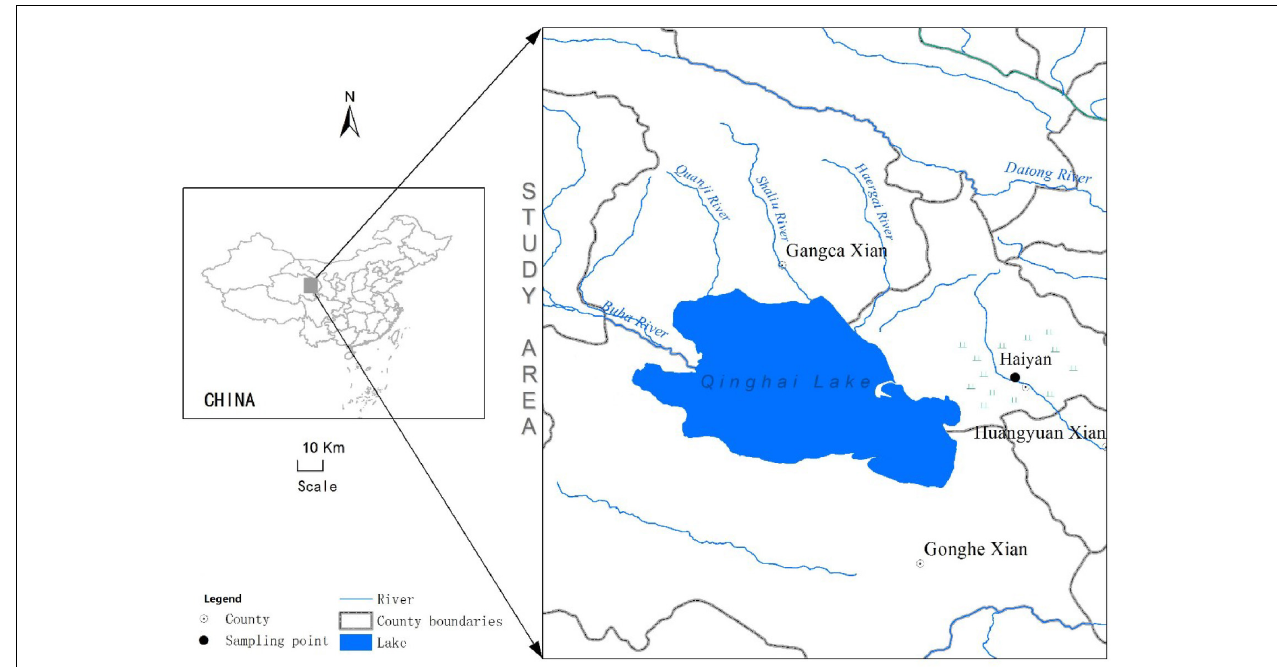
FIGURE 1 | Location of the study site in the Qinghai-Tibetan Plateau of